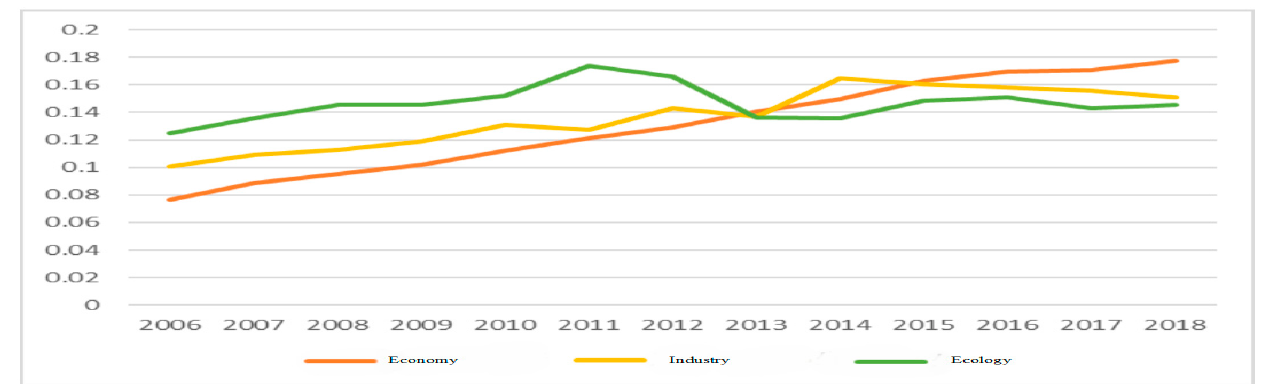
Figure 4. Sequential change of comprehensive development evaluation values of subsystems in the Beijing–Tianjin–Hebei region from 2006 to 2018.